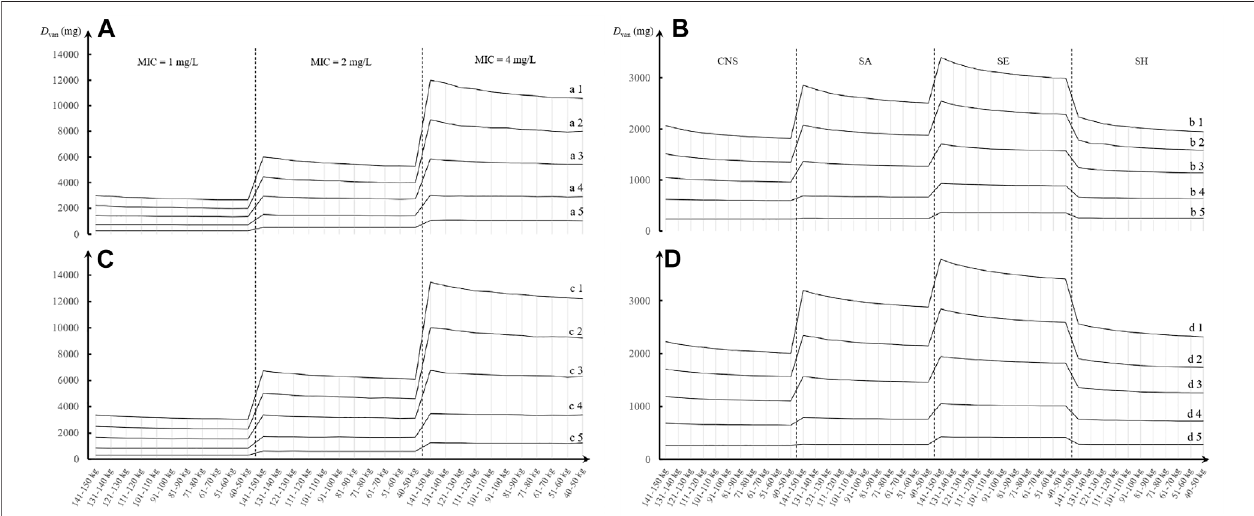
FIGURE4| TrendchartofVAN dailydoseat differentTBW, CL cr ,andMIC orpathogen species basedon MCSs( N =5,000). (A,C) Dailydosedividedevery8 hfor differentMICs; (B,D) dailydosedividedevery12 hfordifferentpathogenpopulations.a1,b1,c1,andd1: CL cr =121 – 150 ml/min;a2,b2,c2,andd2: CL cr =91 – 120 ml/ min; a3, b3, c3, and d3: CL cr = 61 – 90 ml/min; a4, b4, c4, and d4: CL cr = 31 – 60 ml/min; and a5, b5, c5, and d5: CL cr = 10 – 30 ml/min. CNS, coagulase-negative Staphylococcus ; SA, Staphylococcus aureus ; SE, Staphylococcus epidermidis ; SH, Staphylococcus haemolyticus .